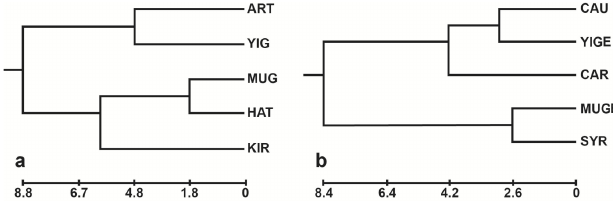
Fig 5. UPGMA dendogram constructed from Mahalonobis Distance